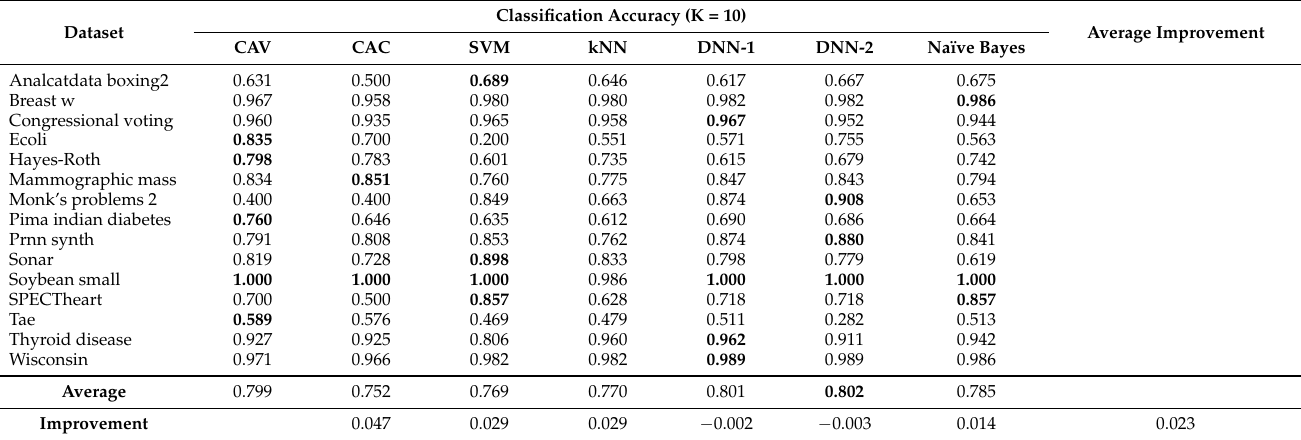
Table 6. The recall of the proposed CAV compared with CAC, SVM, k-NN, DNN-1, DNN-2 and naïve Bayes (the bold number indicates the maximum value).